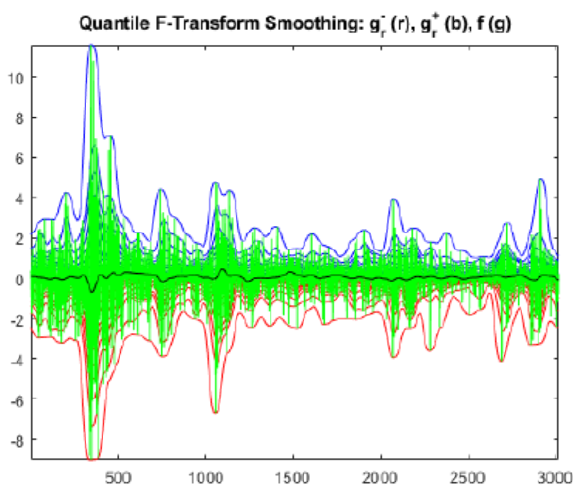
Figure 6: Quantile smoothing for twelve years of daily S&P500 index returns. Figure 6. Quantile smoothing for twelve years of daily S&P500 index returns.